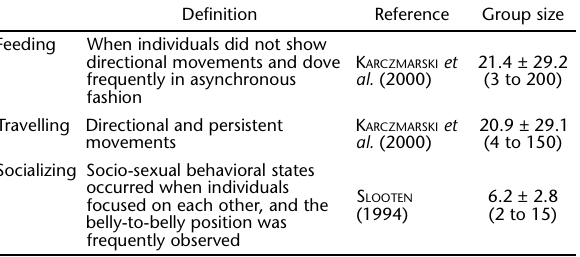
Table I. Definitions and group size for each behavioral state observed in Guiana dolphins’ population in Ilha Grande bay, Rio de Janeiro,